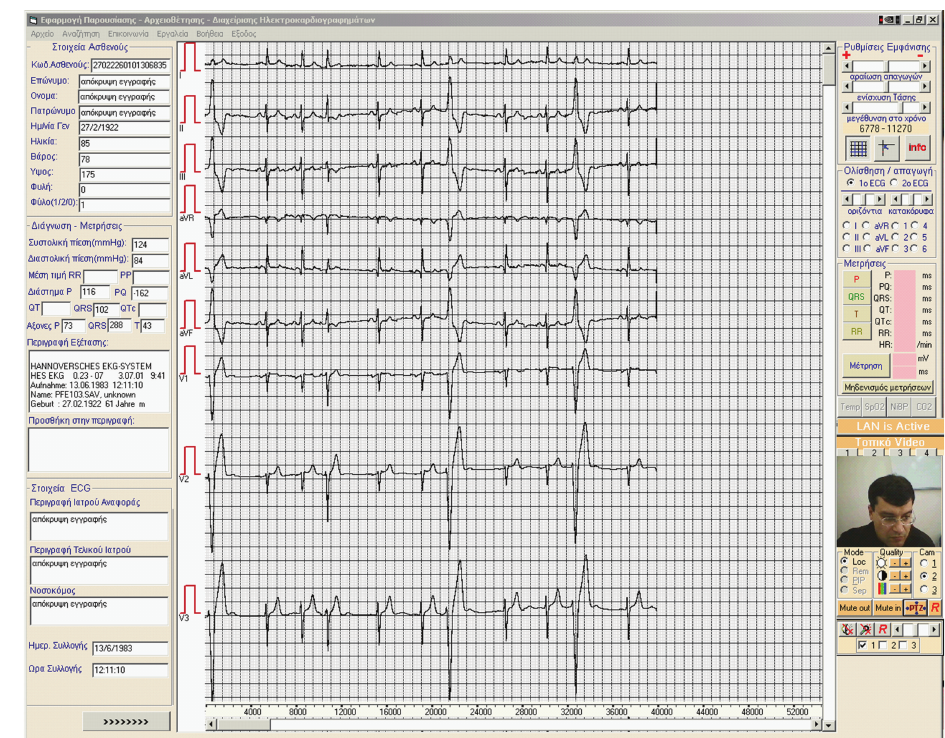
Figure 12: The main screen of the used application on RHMS.